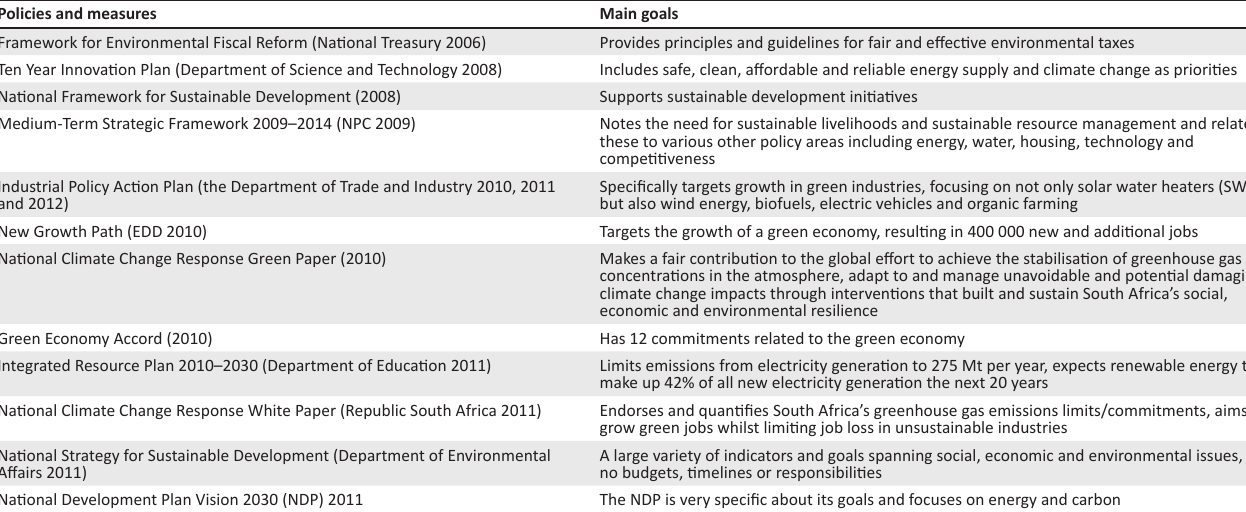
TABLE 2: Selected climate change policies and their main goals in South Africa. Policies and